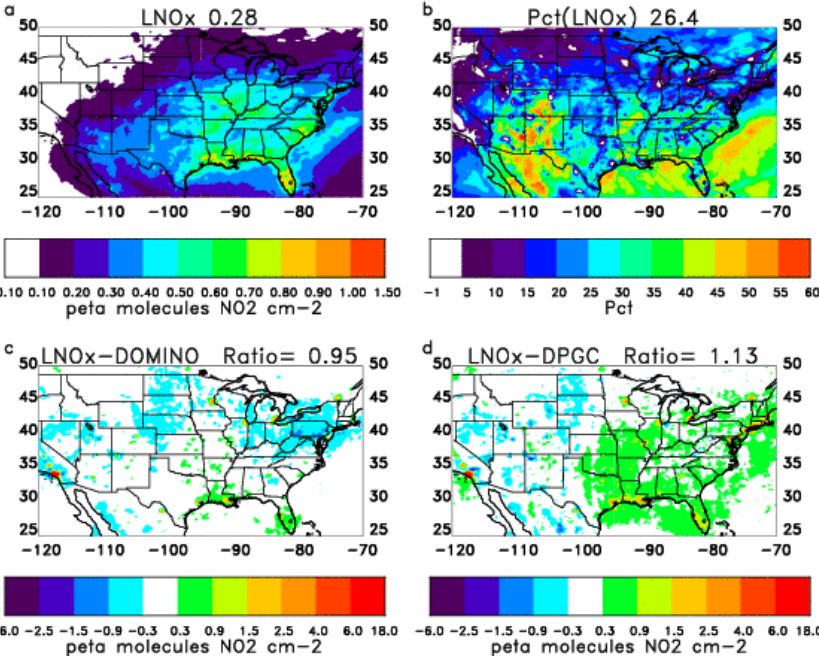
Fig. 5. Contribution of lightning-NO to mean tropospheric NO 2 columns during the summer of 2006 and column biases with respect to satellite-retrieved columns. The upper left panel shows the increase in NO 2 column due to LNO x (petamoleculescm − 2 ) . The upper right panel shows the percent of NO 2 column with an LNO x source. The lower left (right) panel shows the bias between the averaging kernel processed NO 2 column from simulation LNO x and the DOMINO (DP-GC) column.